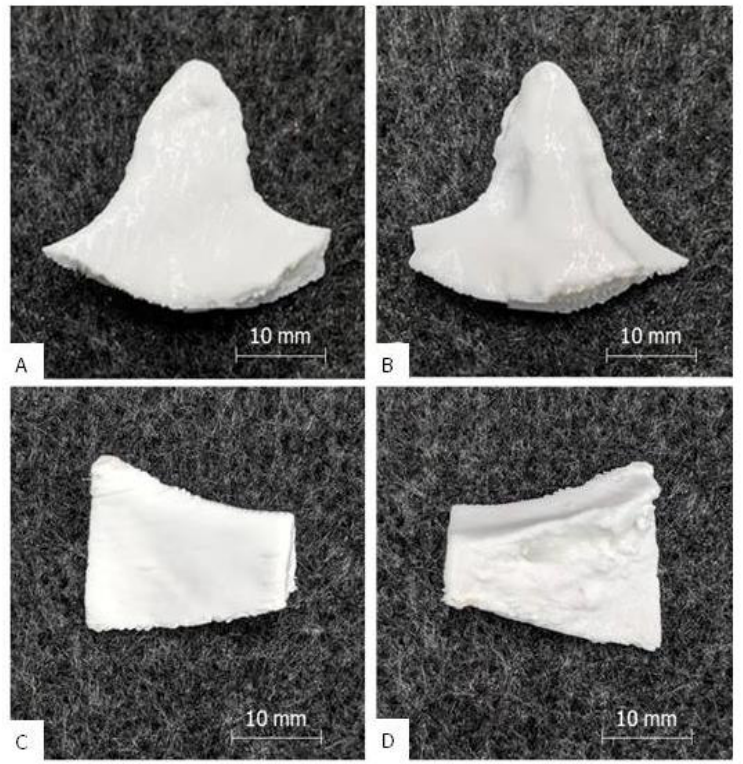
Figure 4. Results of the dual print: picture ( A ) shows the outside of implant B, picture ( B ) the inside; picture ( C ) [7] shows the outside of implant A, picture ( D ) [7] the inside (with porous inner bone structure).